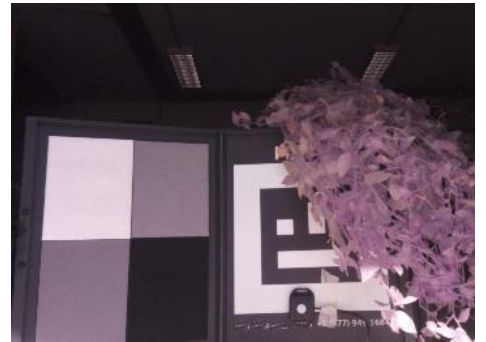
Figure 4. Picture of the calibration scene taken by the NoIR camera. On the left the calibration target composed by four panels (white, light grey, dark grey and black). On the right, side on the picture a plant. At the bottom of the picture is visible the irradiance sensor of the hyperspectral.